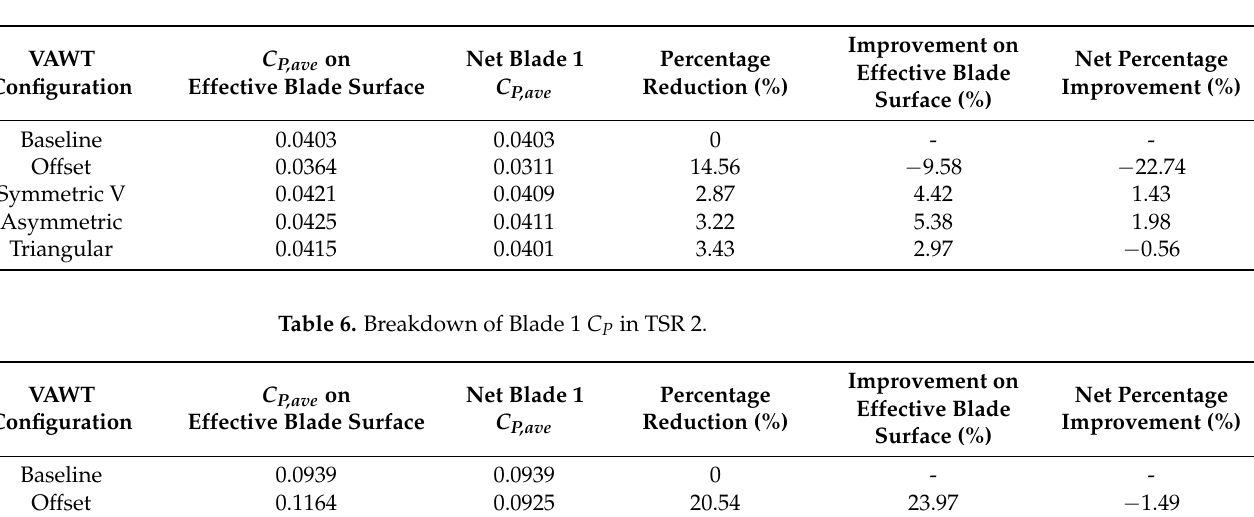
Table 5. Breakdown of Blade 1 C P in TSR 1.